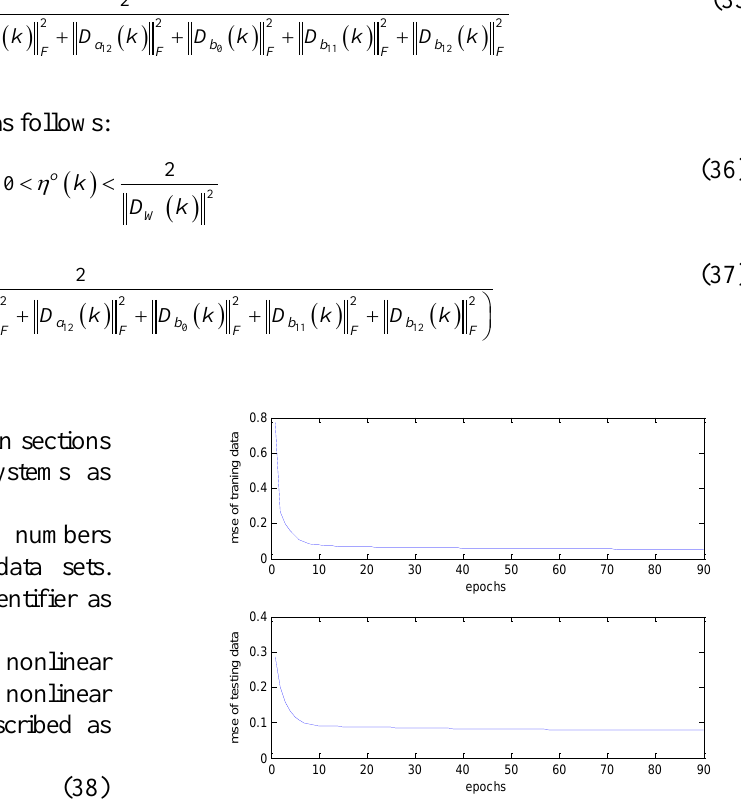
Figure 4. Learning rate is smaller than the upper limit bound.